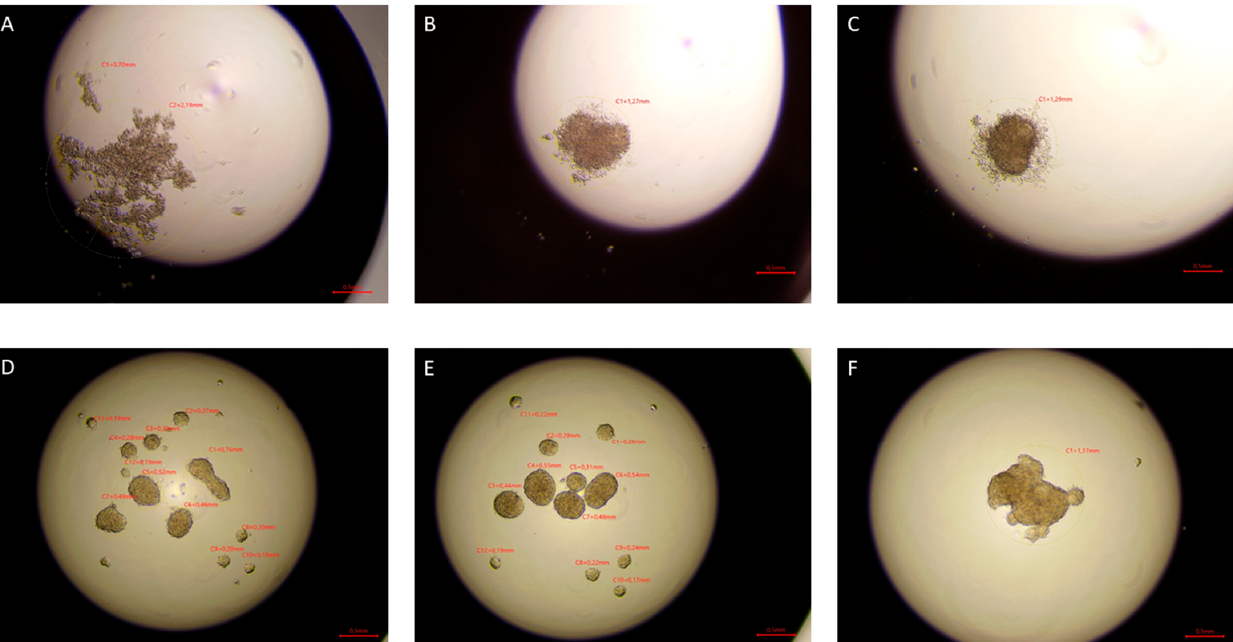
Figure 5. The analysis of the diameter of the spheroid was carried out in 24, 48, and 72 h, the mean values of the diameters of the spheres are presented in the diagram. The analysis was performed with the DLT-Cam Viewer software and the measurements were made from two independent experiments with nine replications. (*— p < 0.05; ***— p < 0.0005).